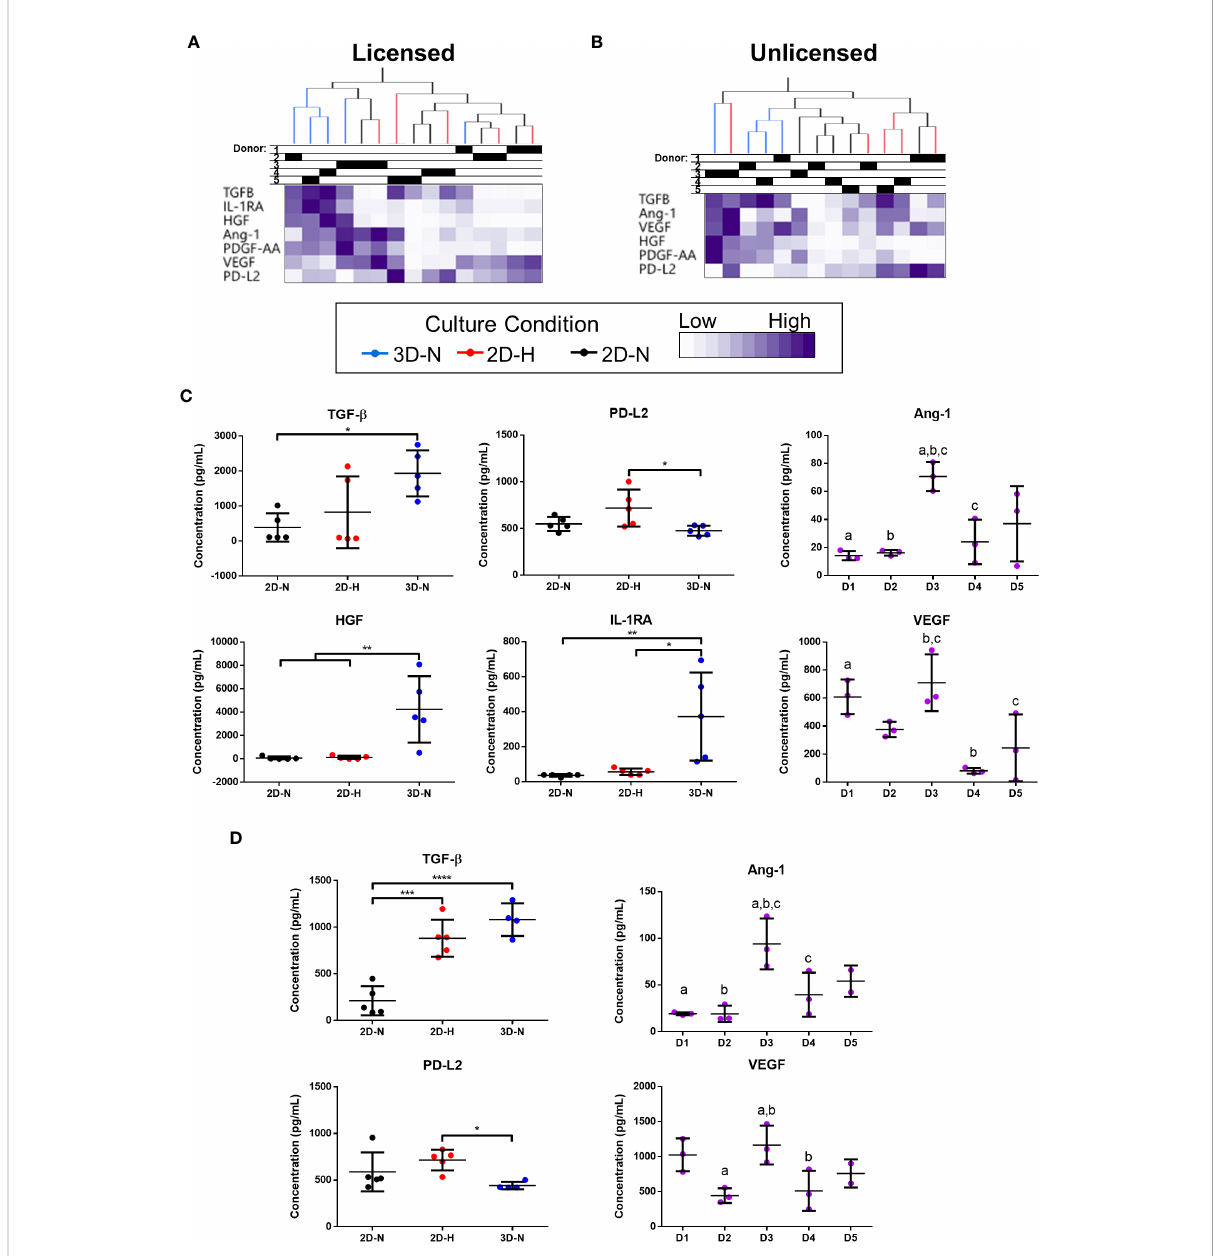
FIGURE 3 Curated anti-in fl ammatory and angiogenic soluble factors were differentially sensitive to donor heterogeneity and select CPPs that enhance immunomodulatory and/or angiogenic potencies. (A, B) Unbiased hierarchical clustering of soluble factors demonstrated clustering by CPPs and donor under Licensed (A) and Unlicensed (B) conditions. (C, D) Soluble factors with statistically signi fi cant differences between CPPs (left) or donors (right) are displayed for Licensed (C) and Unlicensed (D) conditions. One-way ANOVA, Tukey ’ s post-hoc test. *p<0.05, **p<0.01, ***p<0.001, ****p<0.0001. Donors sharing same letter are signi fi cantly different (p<0.05). Horizontal bars: group mean, error bars: standard deviation. Data points represent mean of technical replicates for each donor and condition. 3D-N, 3D Normoxic culture; 2D-N, 2D Normoxic culture; 2D-H, 2D Hypoxic culture. N=5 MSC(AT) donors, n=2 technical